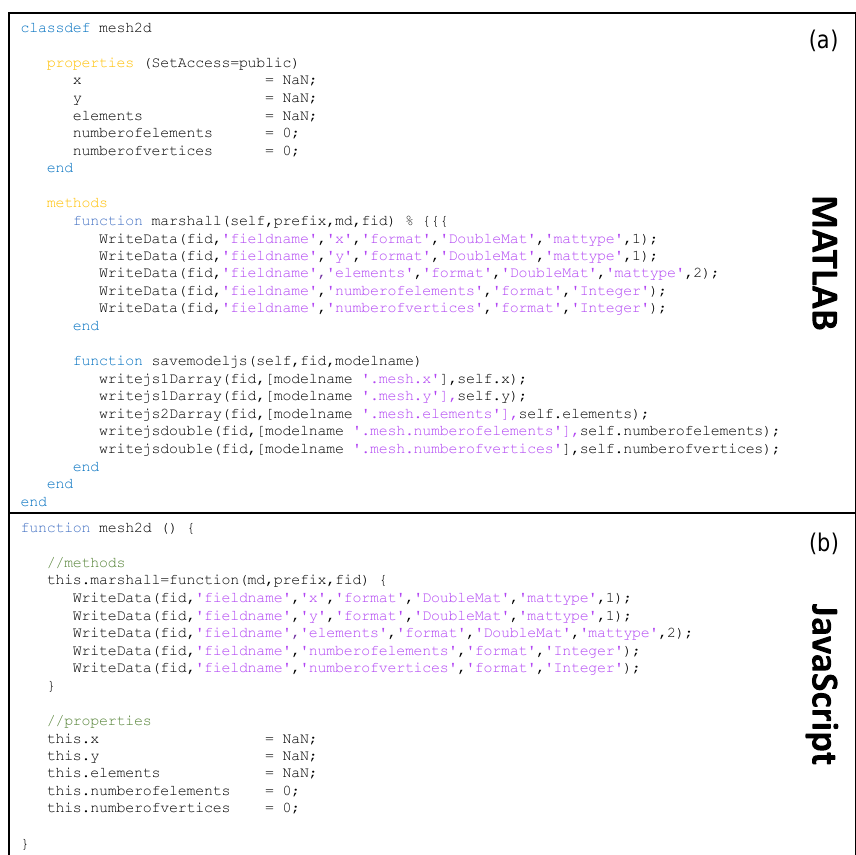
Figure 1. Line-by-line comparison of the code behind the mesh2d class, within the MATLAB ISSM API (upper frame) and the JavaScript ISSM API (lower frame). Class methods that are not relevant to the discussion have been erased for ease of